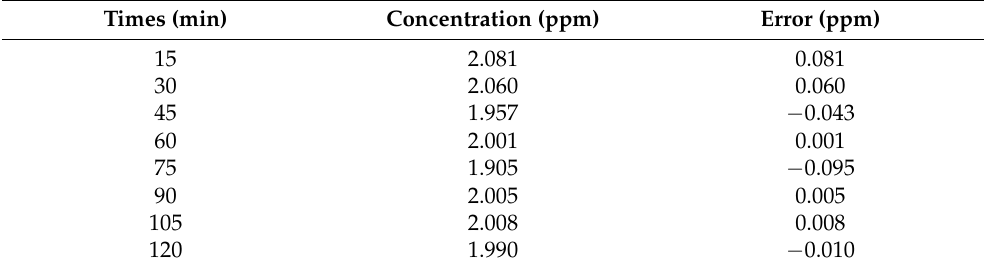
Figure 9. The result of the repeatability experiment. Table 3. The calculated concentration of 2 ppm CH 4 original spectra in the repeatability experiment.